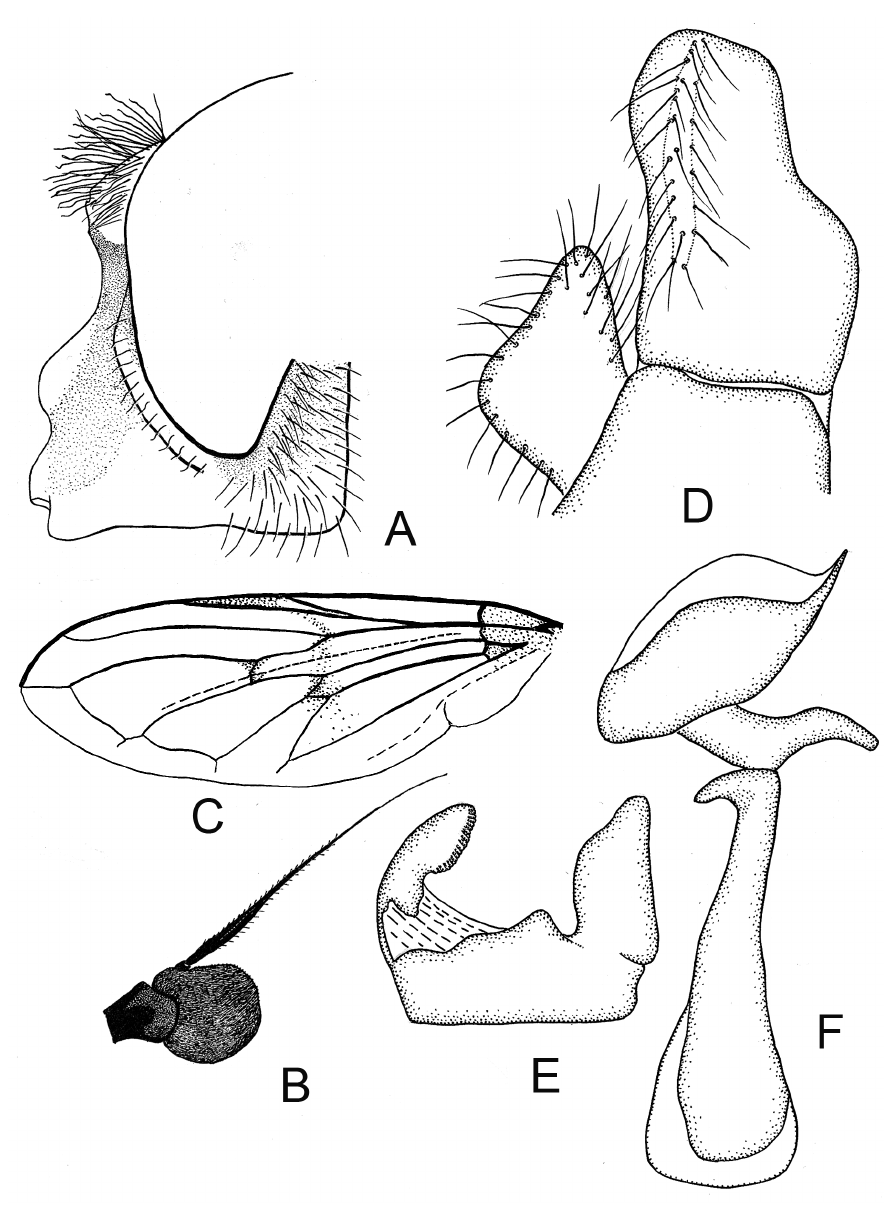
Figure 6. Cheilosia circassica sp. n. male. A Head, lateral view B Antenna, lateral view C Wing D–F male genitalia, lateral, from left to right: D Aedeagal complex E Superior lobe F Cercus+surstylus.